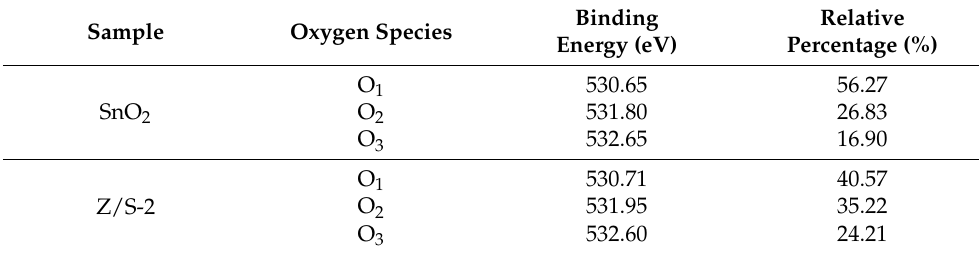
Table 1. The locations of the respective peaks and percentages of the three oxygen components in the O 1s spectra.